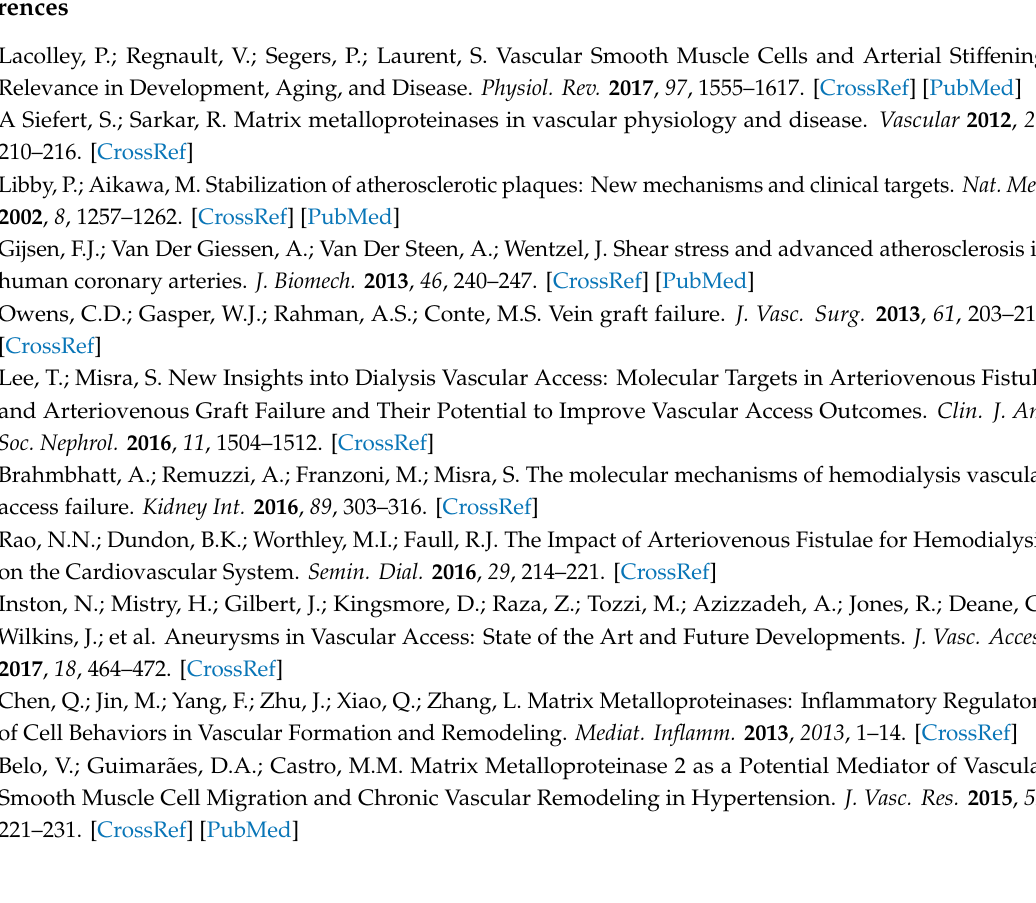
Figure S1: Di ff erence in media area in right common carotid arteries exposed to increased flow, Figure S2: Images from additional mice visualizing the expression of typical smooth muscle cell markers upon increased flow in the right common carotid artery, Table S1: Baseline bodyweight and arterial geometry from WT and KO mice included in the myography experiment, Table S2: Wire myography parameters at optimal stretch in control animals in WT and KO